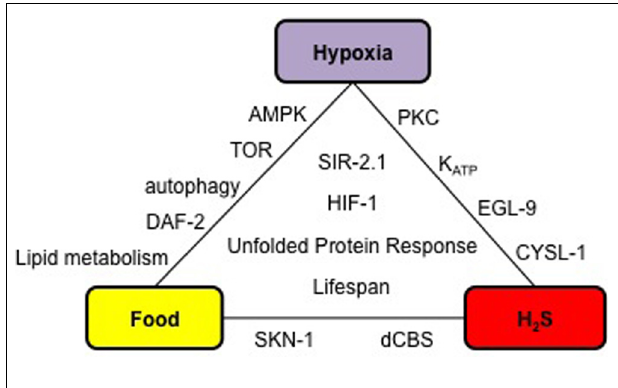
FIGURE 1 | Physiological and molecular relationships between hypoxia, H 2 S signaling, and food. Factors listed inside the triangle are common to all three conditions, and those on the edges are shared by two conditions. Details and references are included in the main text.